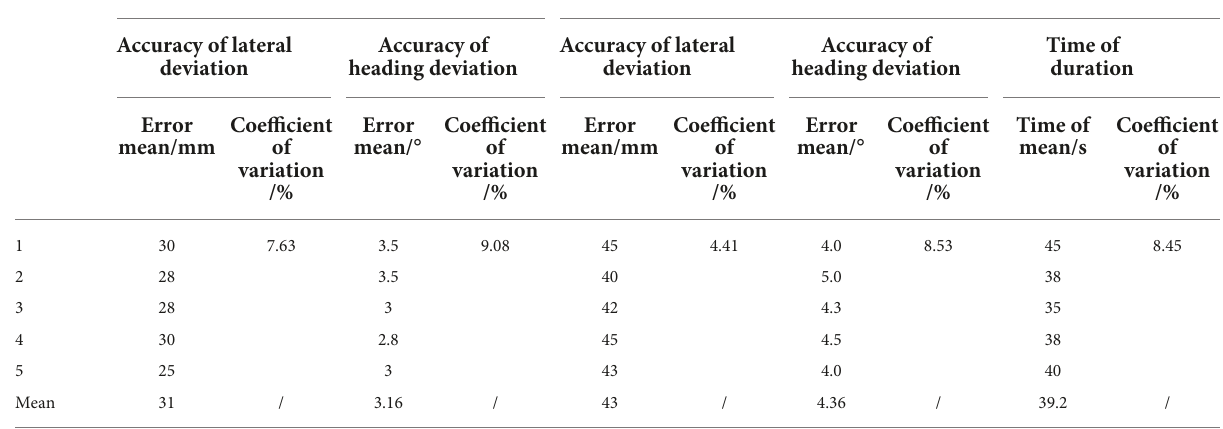
TABLE 7 Test results of detection performance of a normal road edge plane turning to a convex road edge plane. Serial number